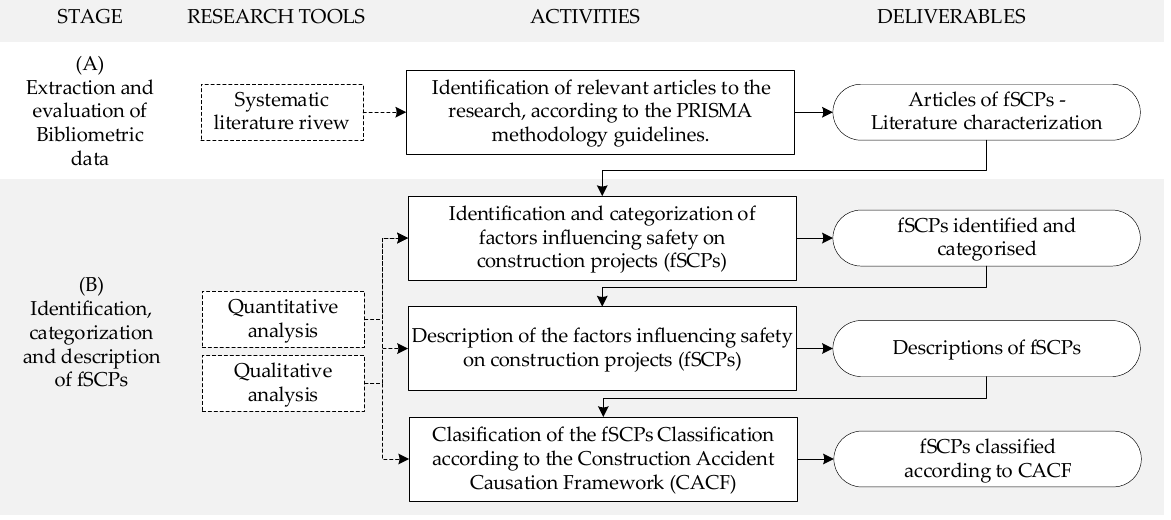
Figure 1. General research methodology.